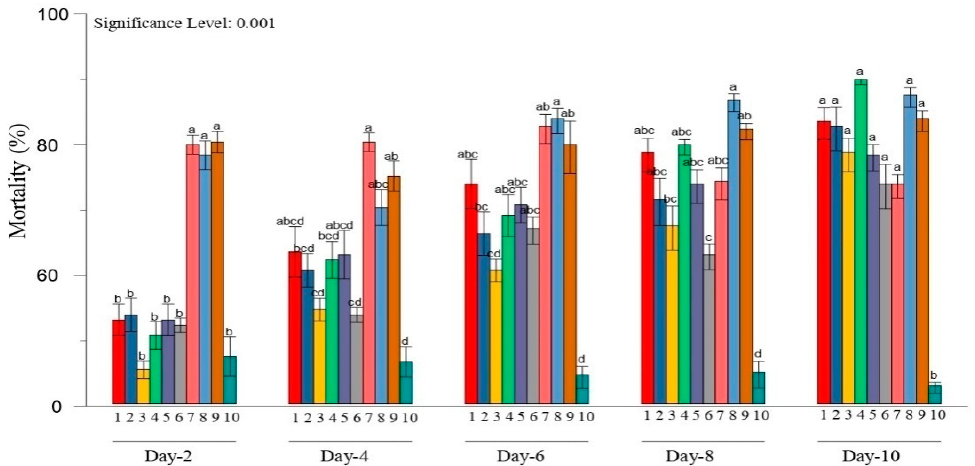
Figure 2. Virulence of entomopathogenic fungi isolates against the H. puera larvae, and statistical differences are shown by different letters (Tukey’s test, p < 0.001). (1–4) M. anisopliae (WnMz1S, NlMz2S, BgMz2S, DhMz4R); (5–7) M. robertsii